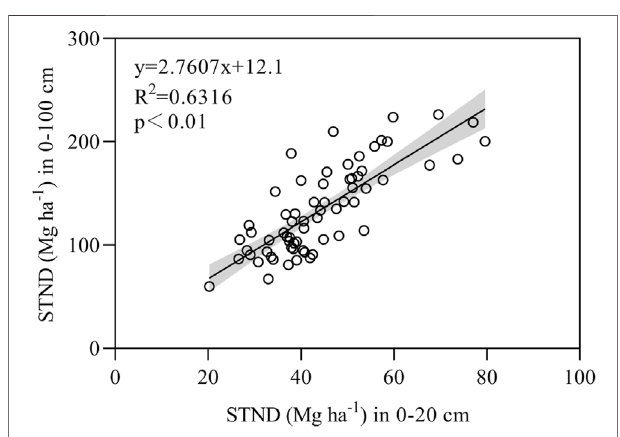
FIGURE 2 | Relationship of total nitrogen density (STND) between 0 – 20 and 0 – 100 cm depths.